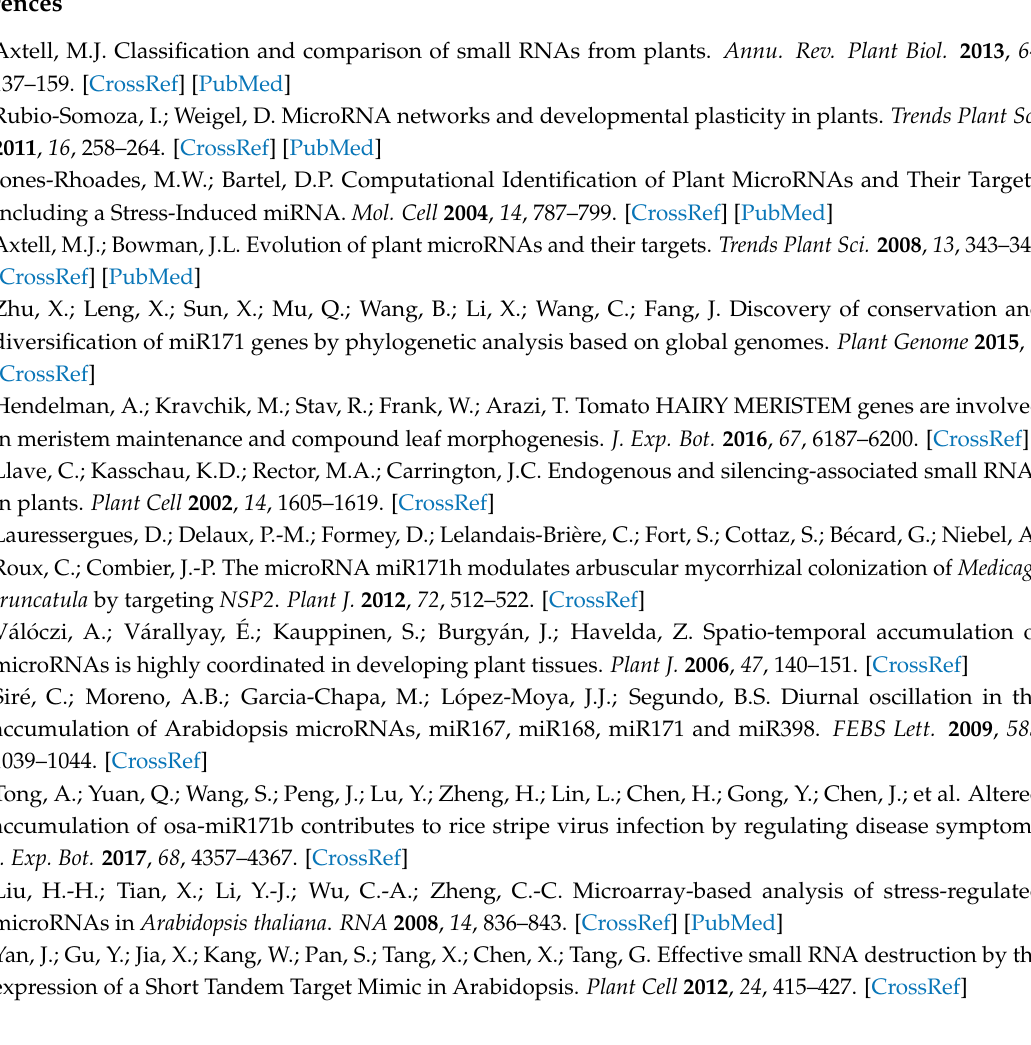
Figure S2. Fruit of 35:STTM171 T2 plants. Figure S3. Determination of the specificity of sly-miR171a, b, e RNA gel blot probes. Figure S4. Developing 35:STTM171 anthers accumulate reduced levels of sly-miR171. Table S1: A list of sly-miR171 precursors and corresponding miRNA/miRNA* pairs. Table S2: psRNATarget analysisa